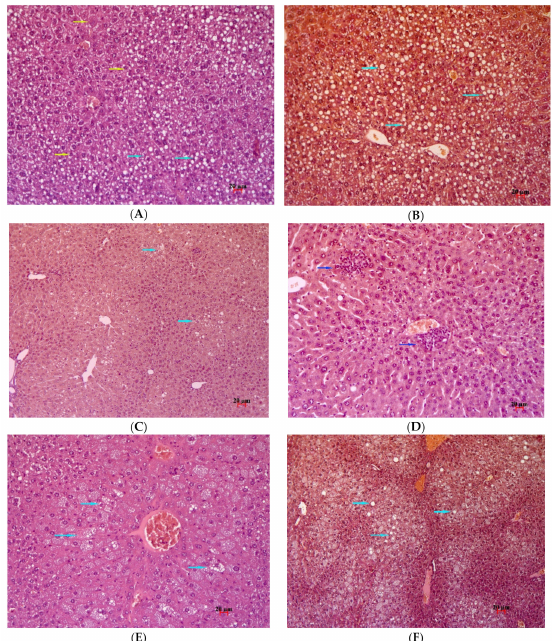
Figure 7. Histological examination of the liver of AY mice treated with VIL or compound 1 or 3 . ( A ) The liver of an AY mouse after 14 days of VIL administration. Polymorphic lipid infiltration and hepatocyte polymorphism. Staining: hematoxylin and eosin; magnification × 200. ( B ) The liver of an AY mouse after 14 days of administration of VIL. Polymorphic lipid infiltration, no glycogen. Staining: periodic acid–Schi ff , hematoxylin, and orange G; magnification × 200. ( C ) The liver of an AY mouse that received 1 for 14 days. Polymorphic lipid infiltration, no glycogen. Staining: periodic acid–Schi ff , hematoxylin, and orange G; magnification × 200. ( D ) The liver of an AY mouse that received 1 for 14 days. Fine necrosis of hepatocytes. Staining: hematoxylin and eosin; magnification × 200. ( E ) The liver of an AY mouse who received 3 for 14 days. Small-vesicle fat dystrophy, hepatocyte hypertrophy. Staining with hematoxylin and eosin; magnification × 200. ( F ) The liver of an AY mouse that received 3 for 14 days. Small-vesicle fat dystrophy, no glycogen. Staining: periodic acid–Schi ff , hematoxylin, orange G; magnification × 200. Light blue arrow: lipid infiltration, yellow arrow: polymorphic hepatocytes, blue arrow: